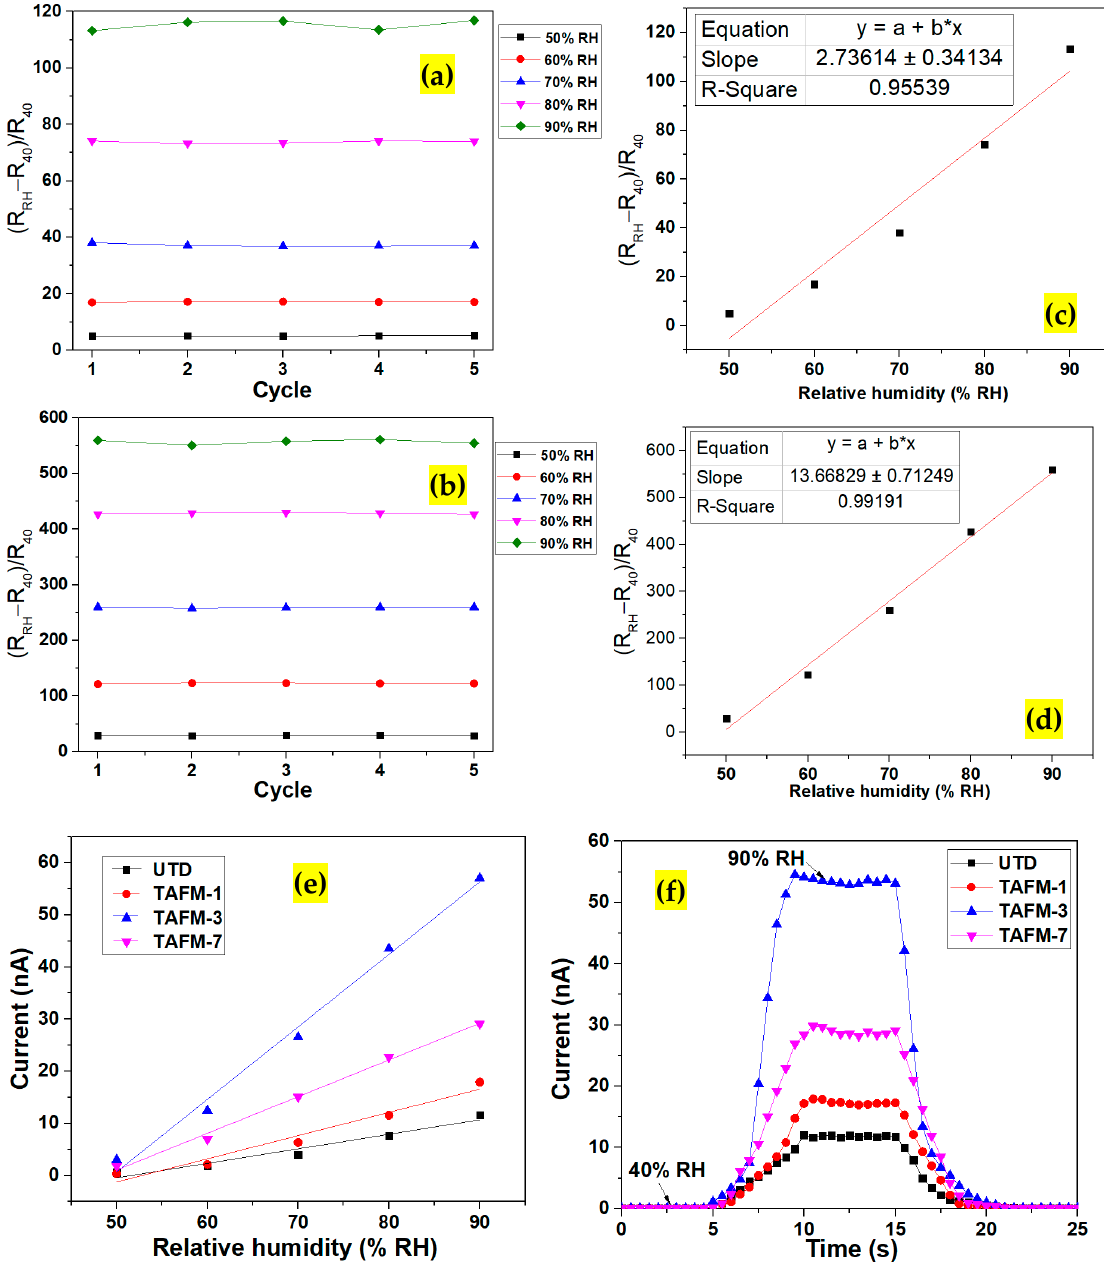
Figure 7. Humidity sensing response of ( a ) UTD and ( b ) TAFM-3 samples over 5 cycles. The transformed humidity sensing response plots of ((R RH –R 40 )/R 40 ) versus relative humidity for ( c ) UTD and ( d ) TAFM-3. ( e ) Static response of humidity sensors based on UTD, TAFM-1, TAFM-3, and TAFM-7. ( f ) Transient response plots of humidity sensors based on UTD, TAFM-1, TAFM-3, and TAFM-7 to humidity change between 40% RH and 90% RH.